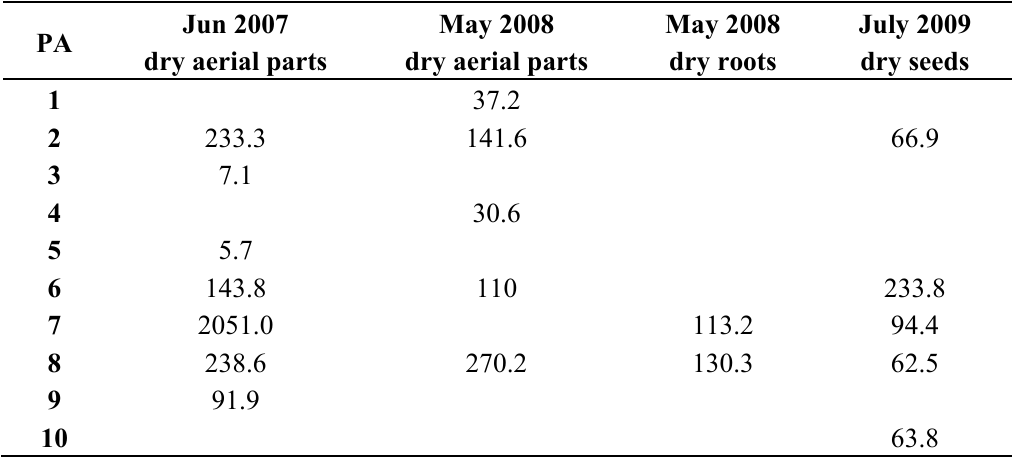
Table 2. Quantities of PAs isolated from different parts of Rindera umbellata , in relation to time of harvest